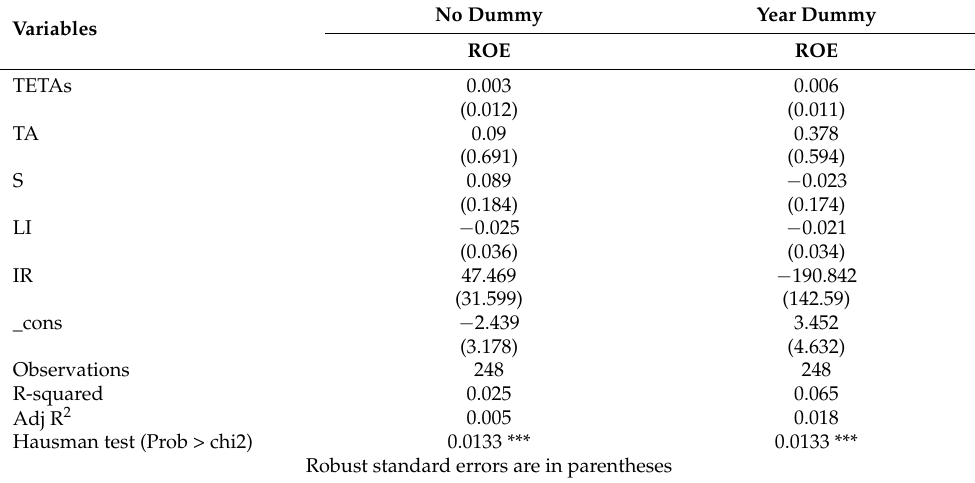
Table 17. Results of the Fixed Effects of TETAs on ROE, as per Panel Data Regression (Loss-Making Sample).